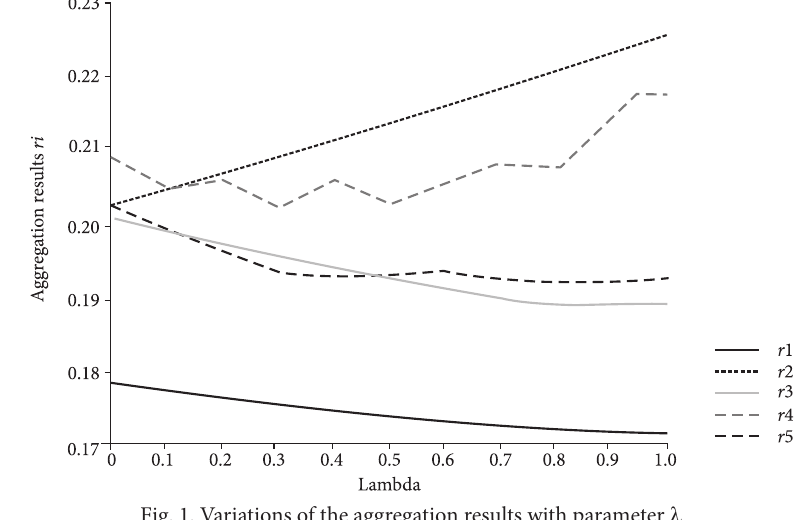
Fig. 1. Variations of the aggregation results with parameter λ